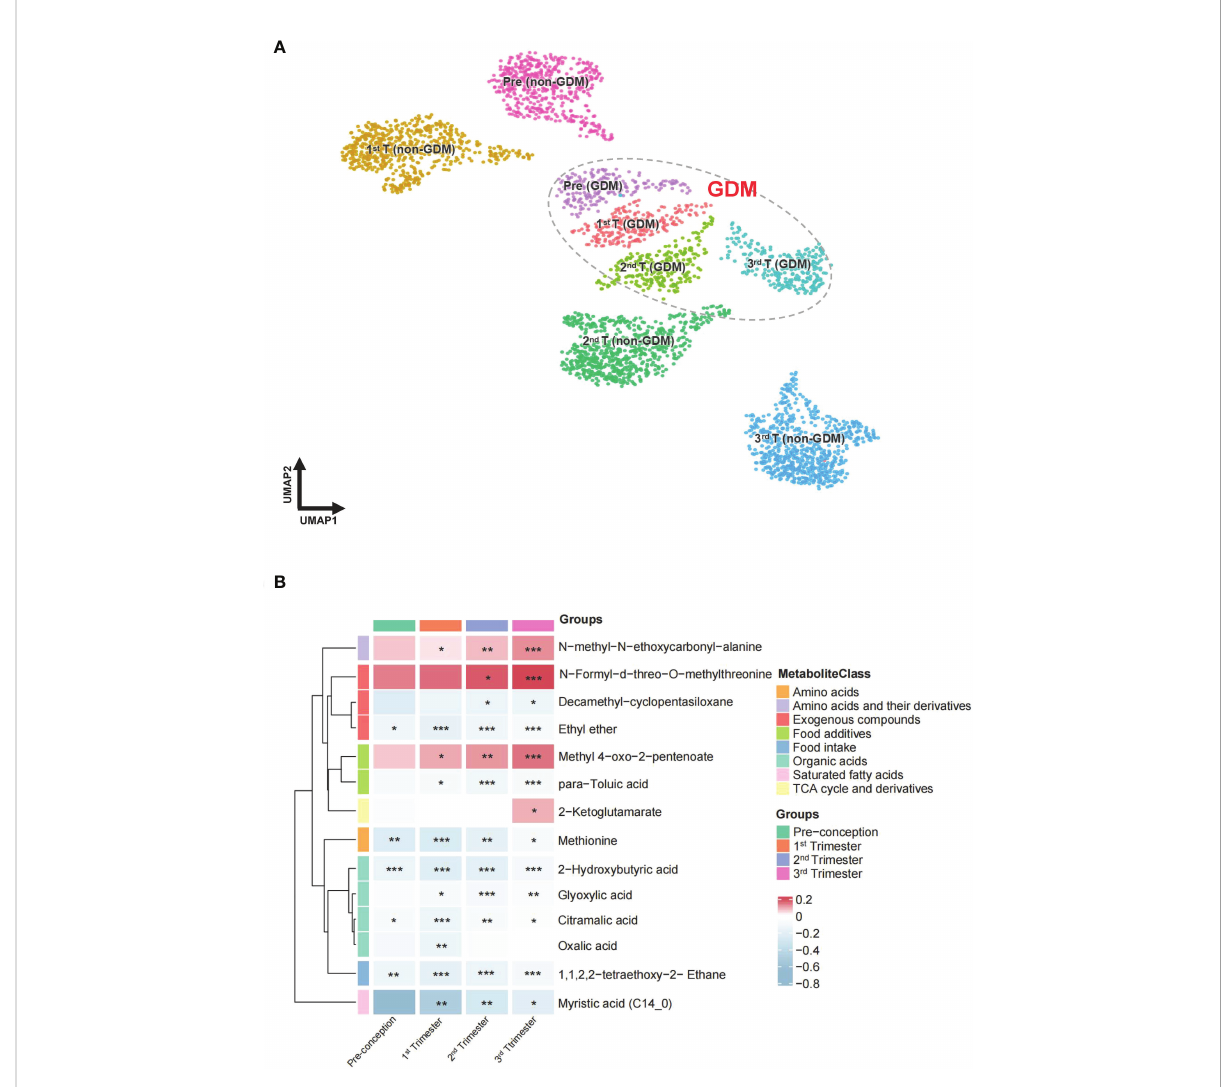
FIGURE 3 UMAP projection and heatmap of the metabolites across pregnancy. (A) UMAP clustering of all participants labelled and colored by GDM status and different periods of gestation. Groupings include pre-conception GDM [pre (GDM)], fi rst trimester GDM [1 st T (GDM)], second trimester GDM [2 nd T (GDM)], third trimester GDM [3 rd T (GDM)], pre-conception non-GDM [pre (non-GDM)], fi rst trimester non-GDM [1 st T (non-GDM)], second trimester non-GDM [2 nd T (non-GDM)], and third trimester non-GDM (3 rd T (non-GDM)). (B) The ratio offourteen metabolite levels signi fi cantly different between GDM case and control groups. Red color indicates higher metabolite levels in the GDM group than the control group, while blue color indicates lower metabolite levels in the GDM group than the control group. Metabolites with both p -value and q -value less than 0.05 in the logistic regression adjusted for age and BMI are marked with * p -value and q -value less than 0.01 are marked with ** p -value and q -value less than 0.001 are marked with